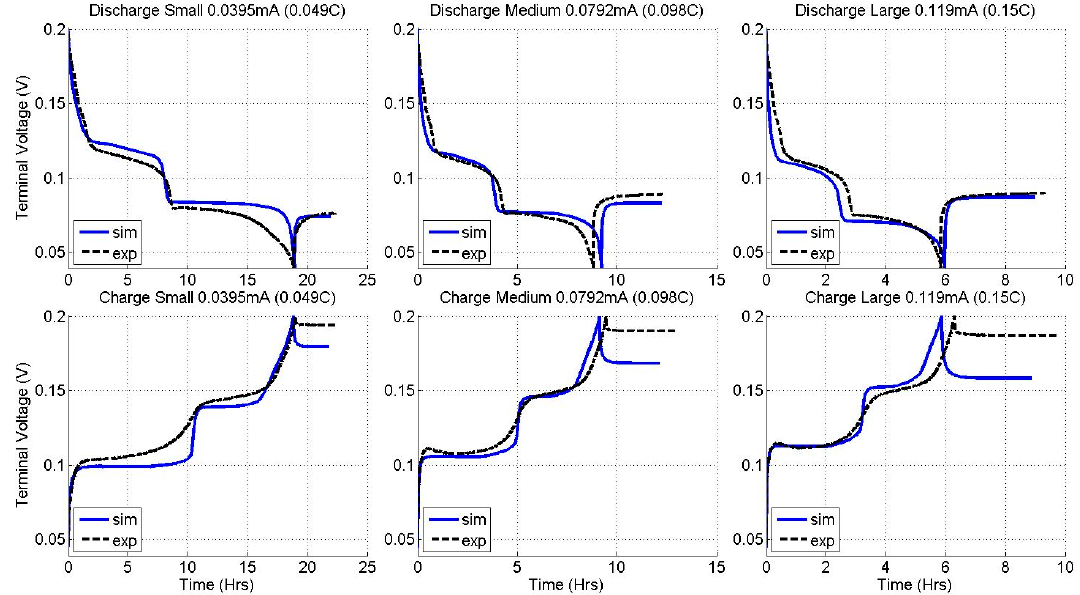
Figure 2. Experimental validation of the terminal voltage of a graphite half-cell at 0.05 C, 0.1 C and 0.15 C cycles.